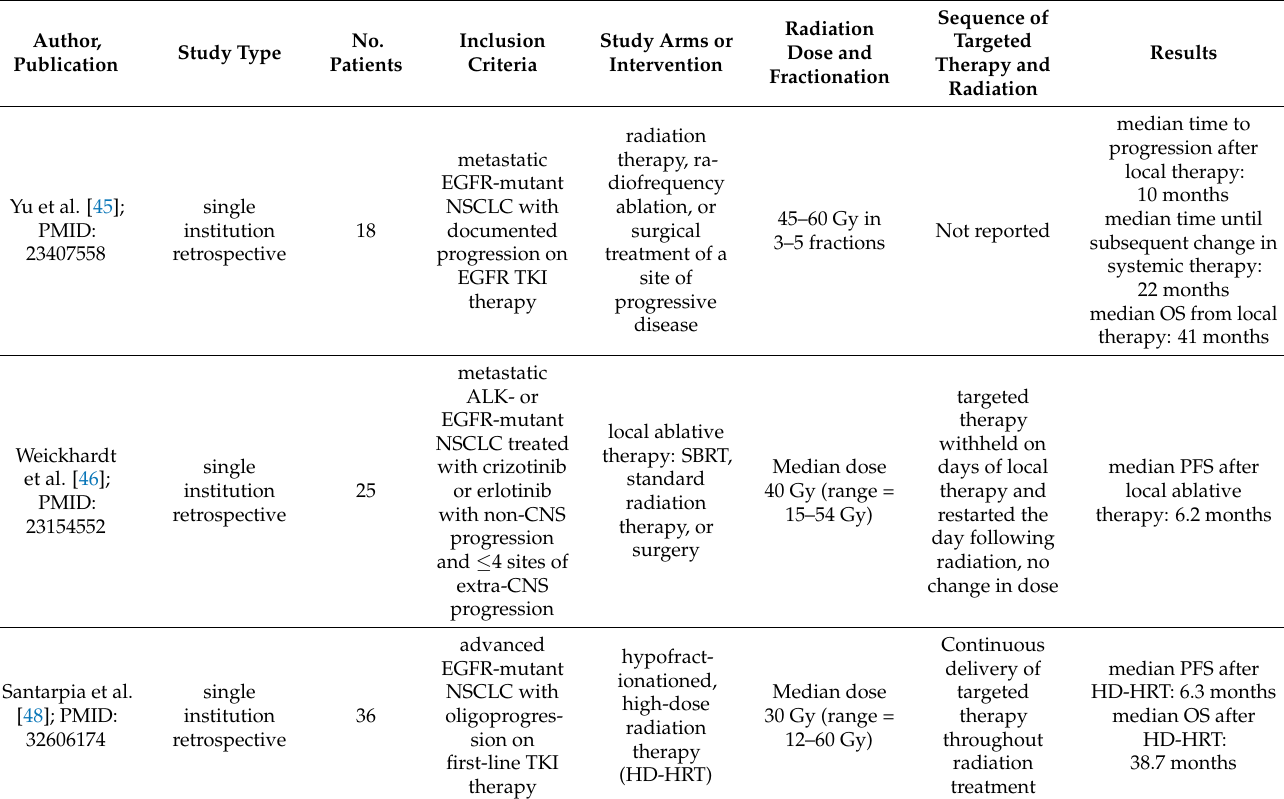
Table 1. Trials evaluating SBRT as a strategy for overcoming acquired TKI resistance in EGFR- mutated